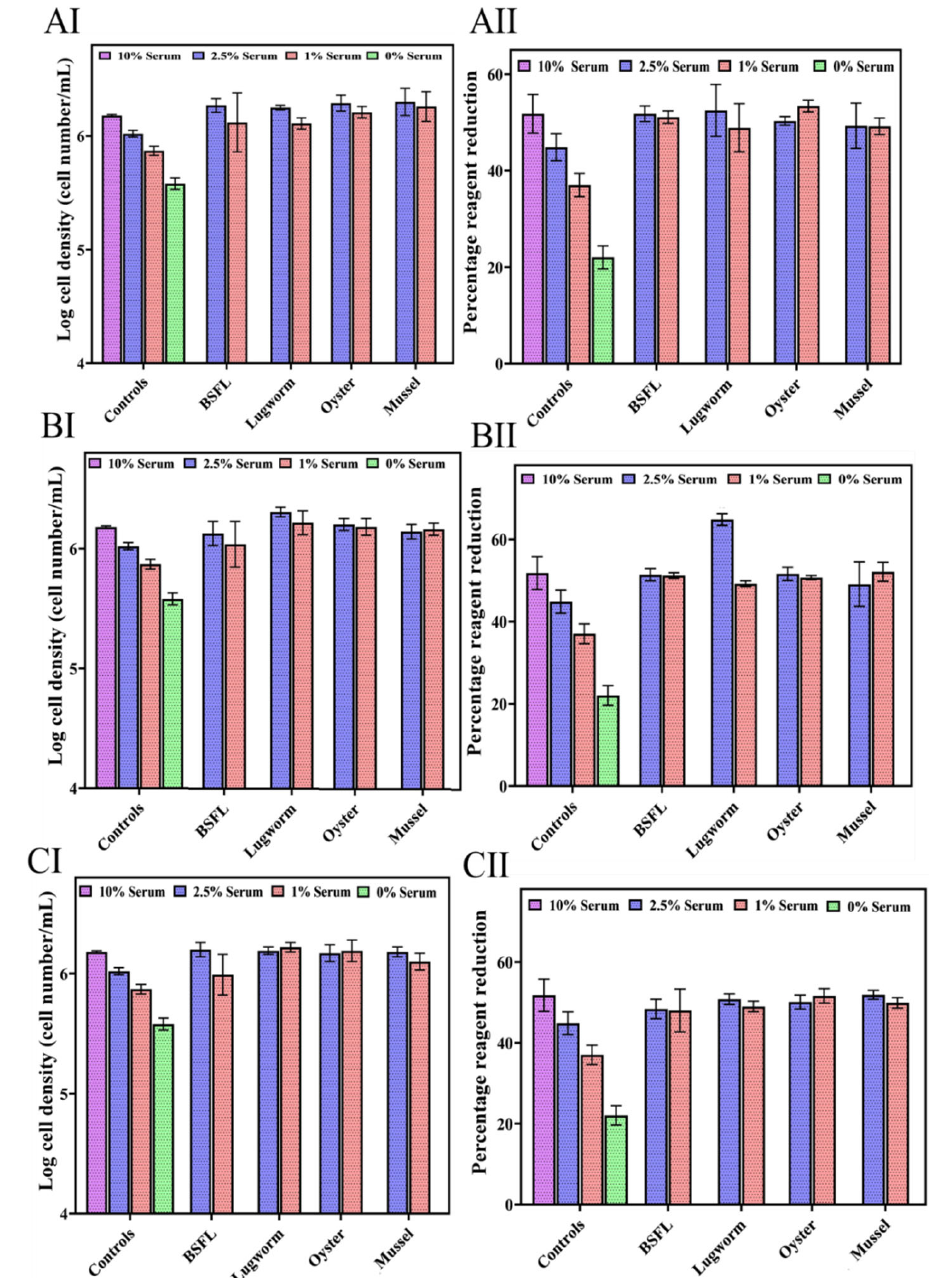
Figure 6. ZEM2S cells’ growth in media containing different serum concentrations (10%, 5% and 0%), ( A ) 0.1 mg/mL protein hydrolysates (AI: cell growth; AII: cell viability); ( B ) 0.01 mg/mL protein hydrolysate (BI: cell growth; BII: cell viability); and ( C ) 0.001 mg/mL protein hydrolysates (CI: cell growth; CII: cell viability).